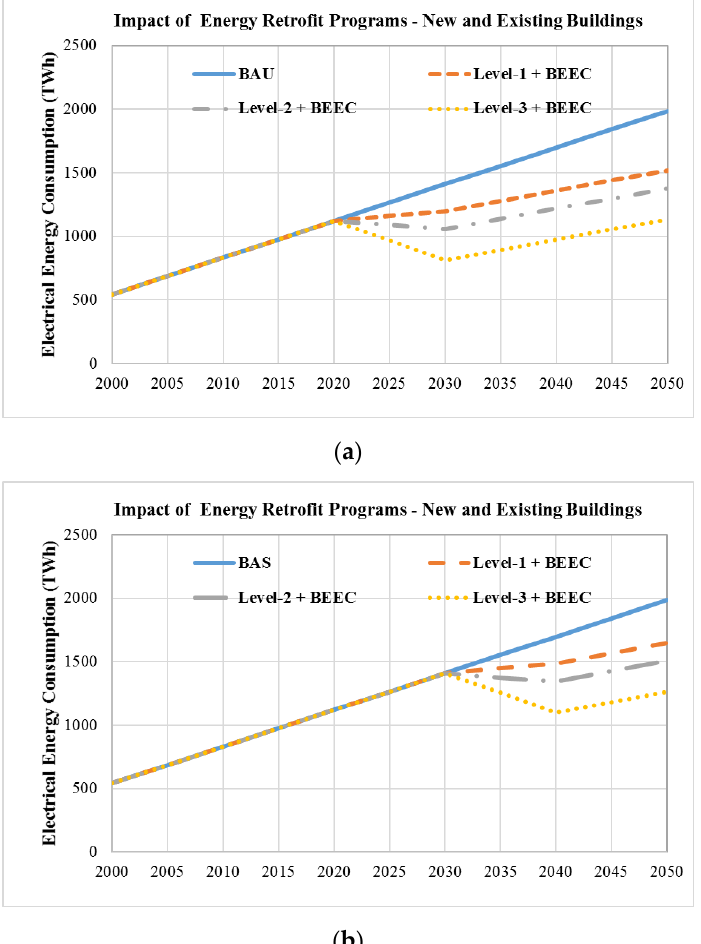
Figure 22. Impact on final energy consumption due to the implementation of both comprehensive energy e ffi ciency code for new buildings and energy retrofit programs for the entire existing building stock when the programs start during ( a ) 2020 and ( b ) 2030.